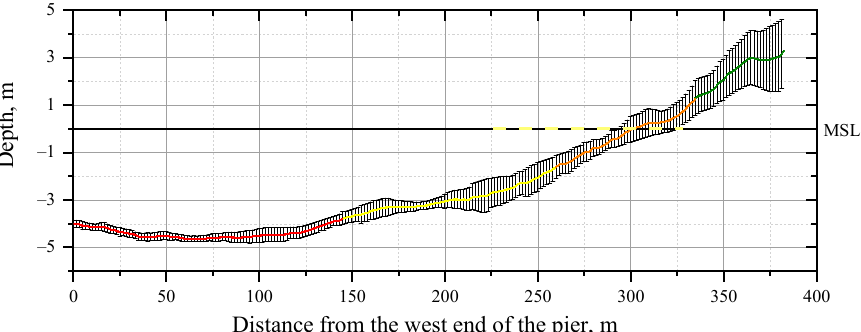
Figure 13. Average of all measured profiles (red 1st, yellow 2nd, orange 3rd and green 4th clusters) with the standard deviation.